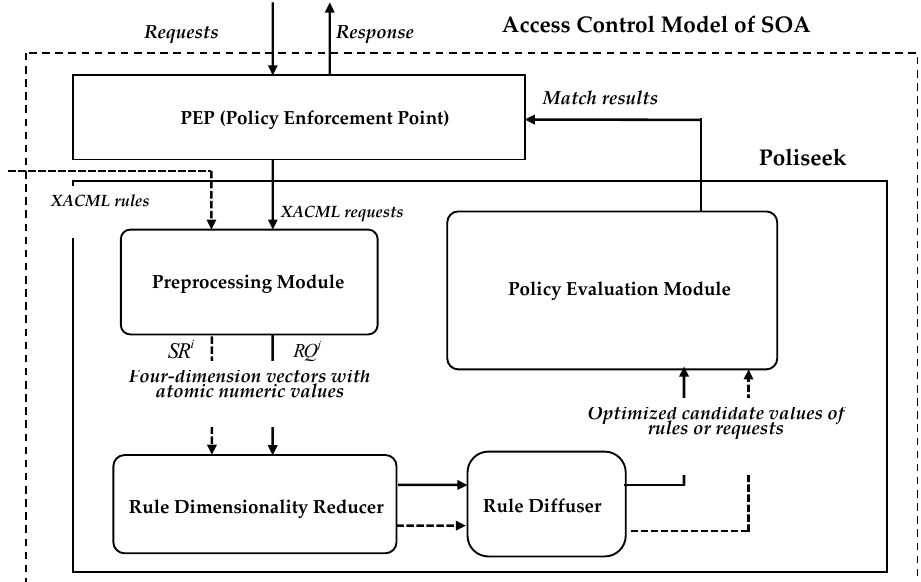
Figure 1. Overall structure of policy evaluation engine Poliseek.